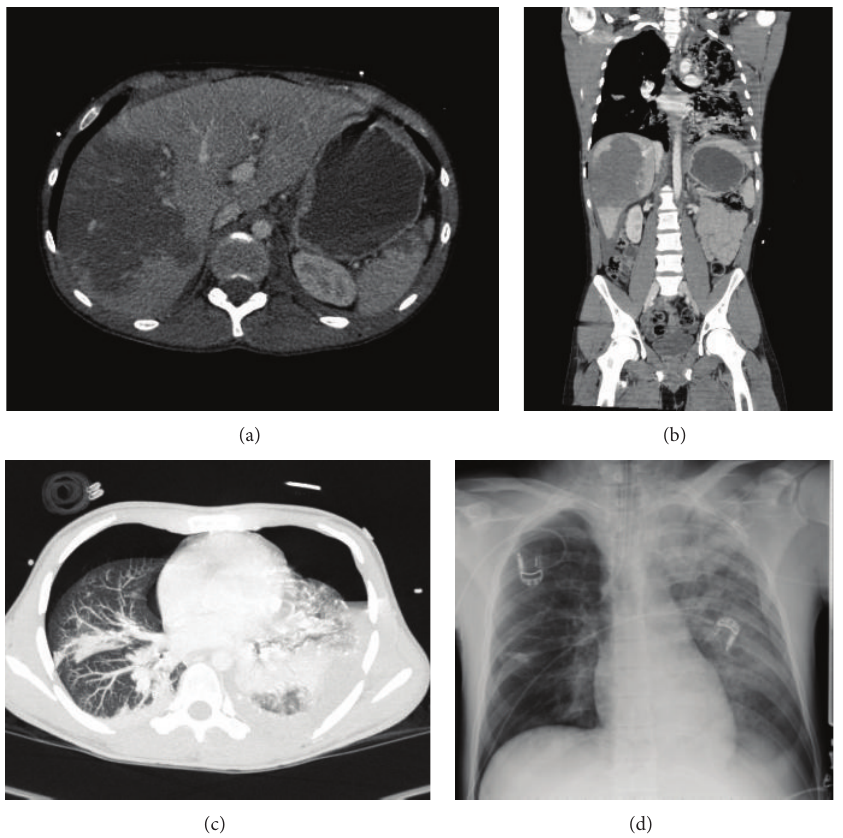
Figure 2: Radiologic evaluation of the intra-abdominal injuries: (a) and (b) imaging of the liver and spleen laceration with consecutive intra- abdominal hematoma in horizontal and frontal planes; (c) and (d) imaging of the hematothorax on the left side and pneumothorax on the right side in the horizontal plane and in conventional